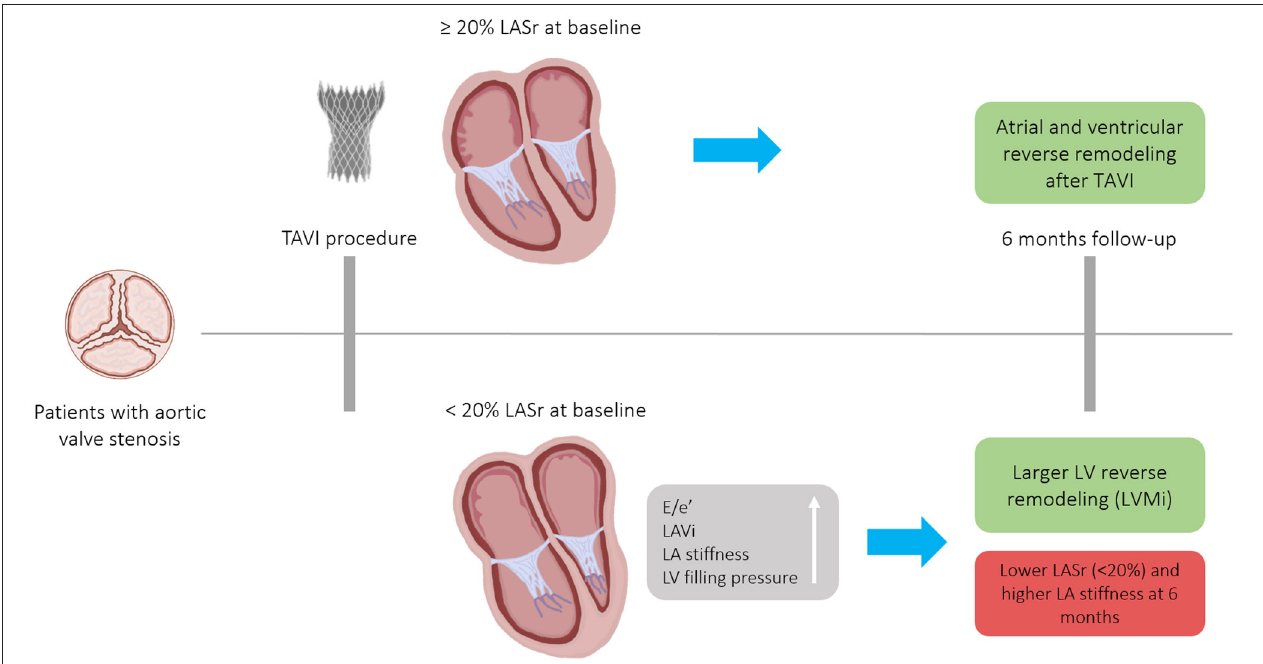
FIGURE 5 | Patients with severe, symptomatic aortic valve stenosis who underwent TAVI experienced atrial and ventricular reverse remodeling after 6-months. The magnitude of anatomical LV and functional LA reverse remodeling was numerically larger in patients with severely reduced baseline LASr ( < 20%), nonetheless, due to the extensive baseline LA remodeling, these patients remained in the severely reduced LASr range 6 months after a successful TAVI. Patients with LASr < 20% had stiffer LA at both time points. E/e’, ratio between early mitral inflow velocity and mitral annular early diastolic velocity; LA, Left atrium; LASr, Left atrial peak reservoir strain; LAVi, Left atrial volume index; LV, Left ventricle; TAVI, Transcatheter aortic valve implantation; LVMi, Left ventricular mass